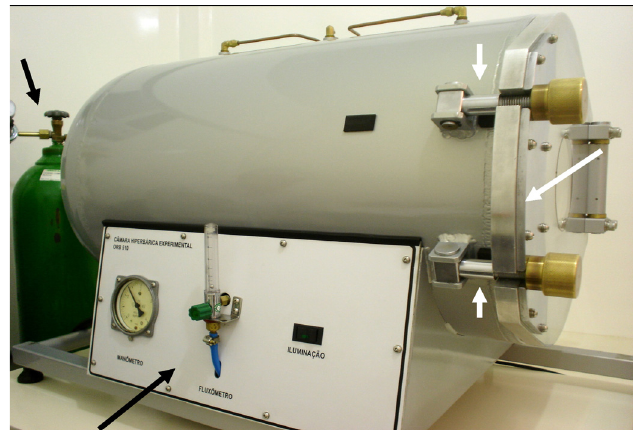
FIGURE 3 – Lateral view of the hyperbaric chamber showing the cover (white long arrow) closed with security latches (short white ar- rows) and the control panel (long black arrow). In the posterior part, the oxygen cylinder is distinguished (short black arrow)